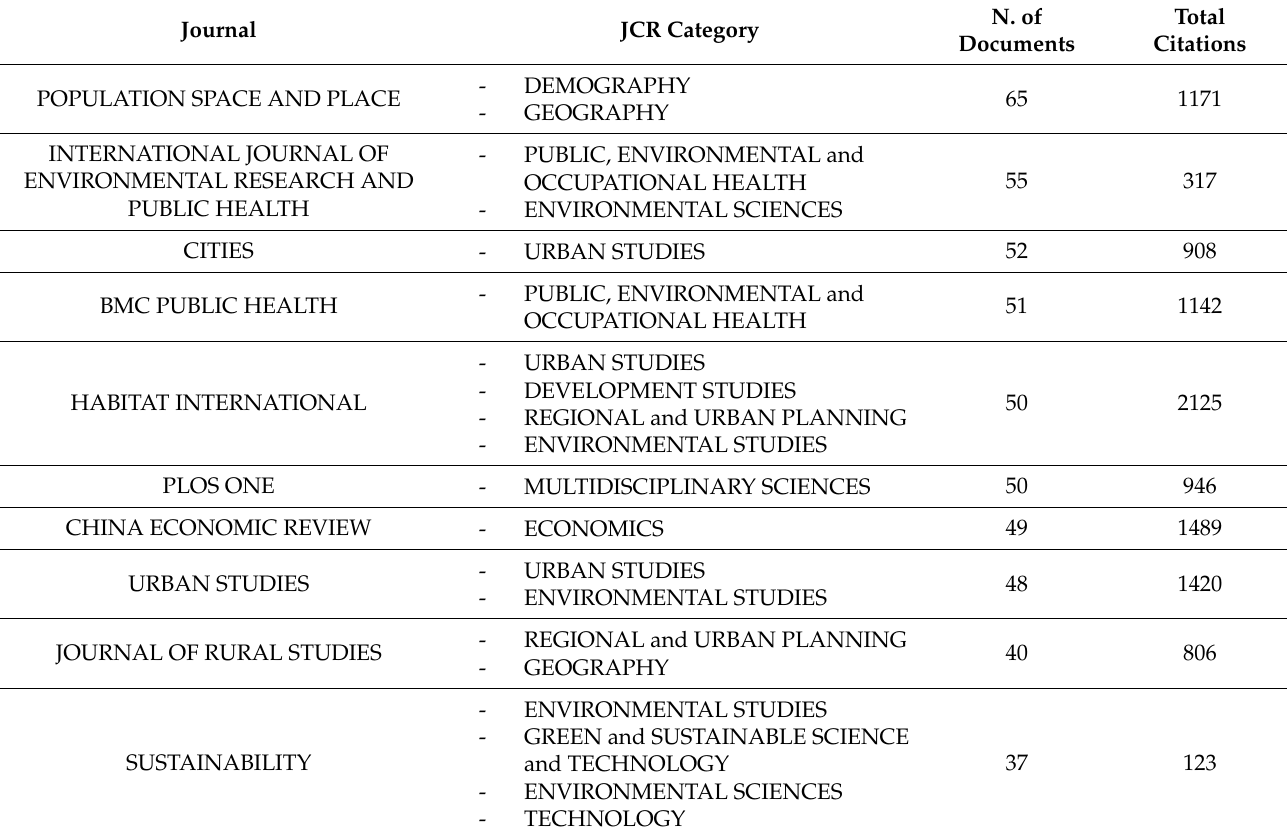
Table 2. Top 10 journals with the most articles published on the topic of rural-to-urban migrants (1 January 2004–3 June 2022).